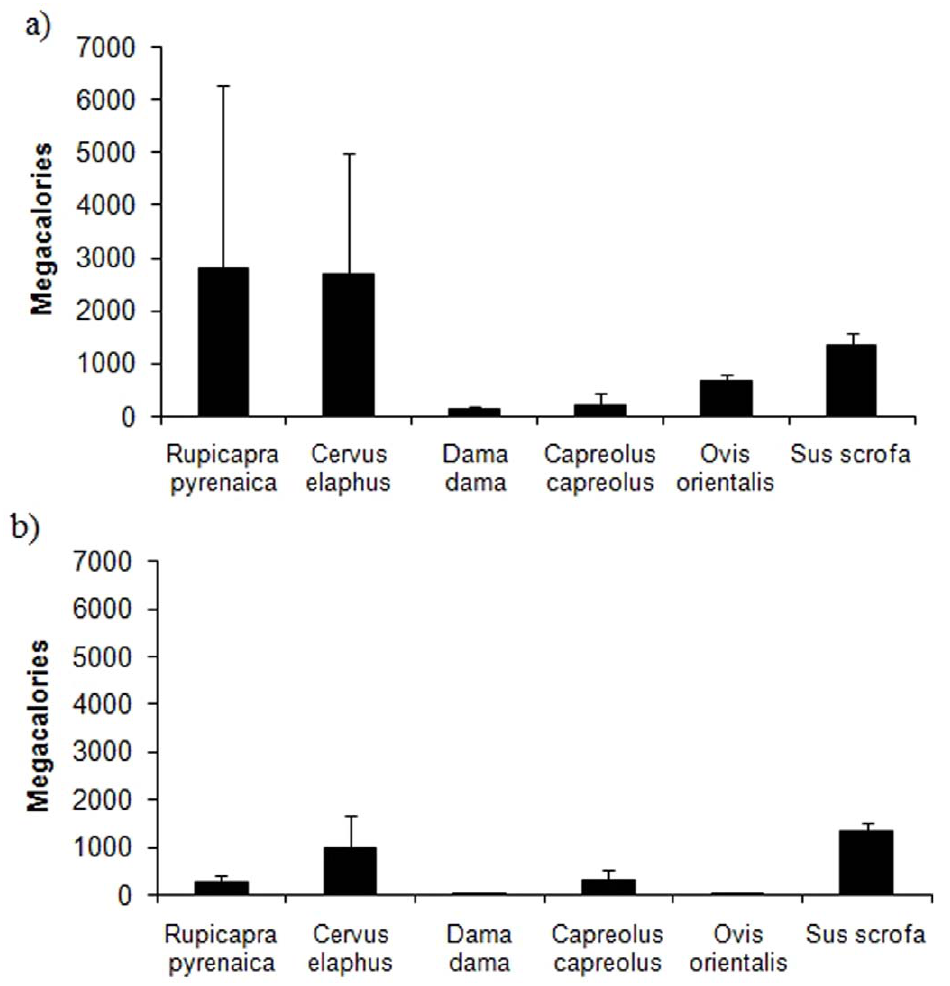
Figure 2. Average biomass (megacalories ± 1 SD) provided (bones and meat) by the different wild ungulate species in the Pyrenees (a) and Pre-Pyrenees (b). The columns represent the average biomass provided during the 15 years simulated.